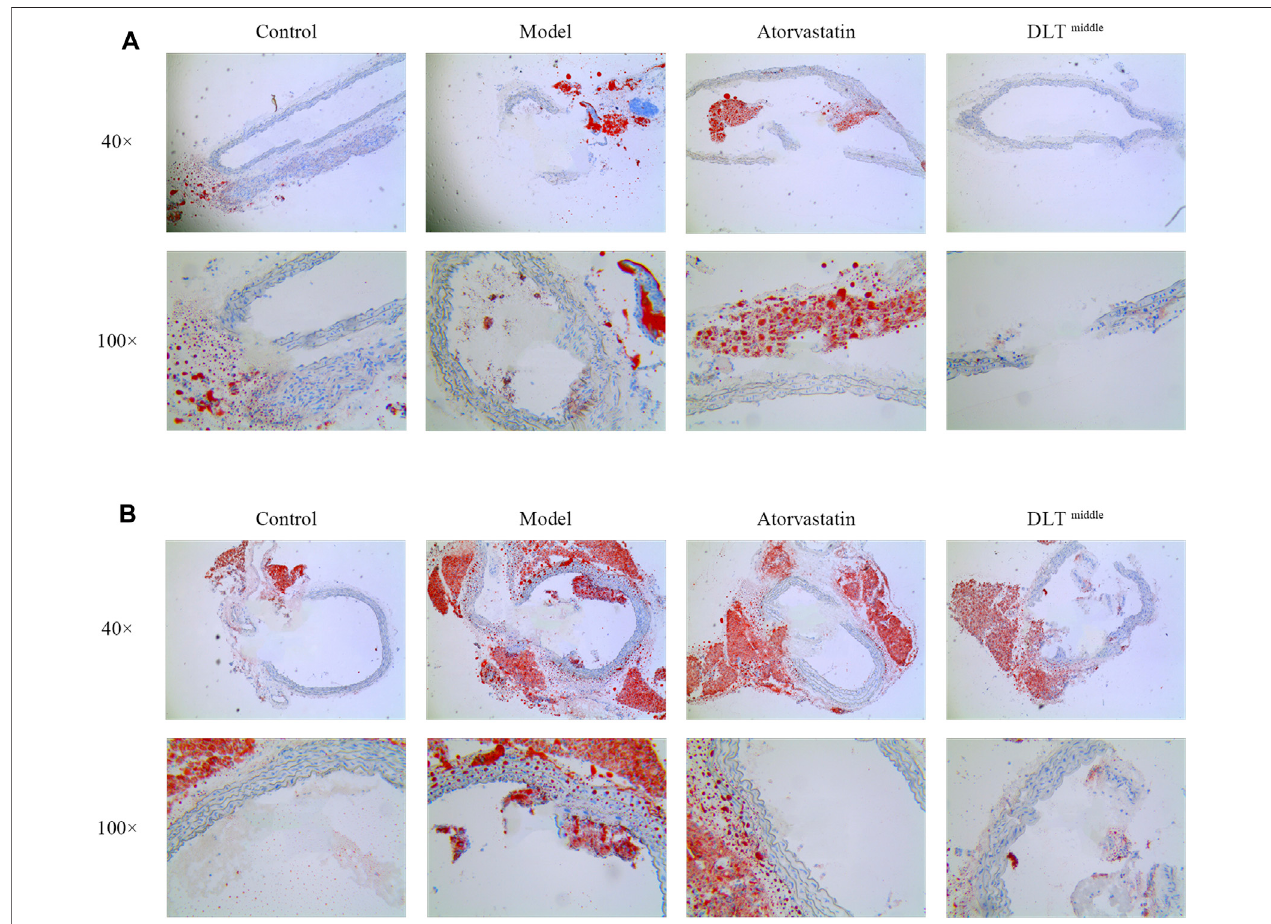
FIGURE 2 | DLTs reduced intracellular lipid droplet accumulation in the aorta and left carotid artery of ApoE - / - mice. Intracellular lipid droplet accumulation was observedbyoilredOstaininginthecarotid (A) andaortic (B) arteries.Imagesrevealedthemostsevereintracellularlipiddropletdeposition(inred)inthevesselwallofthe modelgroups,whileitwasmarkedlyreducedintheDLT-middlegroupinaortictissueandcarotidtissuecomparedwiththemodelgroup,sodidtheatorvastatingroupin aortic tissue. No signi fi cant difference in lipid droplet deposition was seen between the atorvastatin group and the model group in carotid tissue.